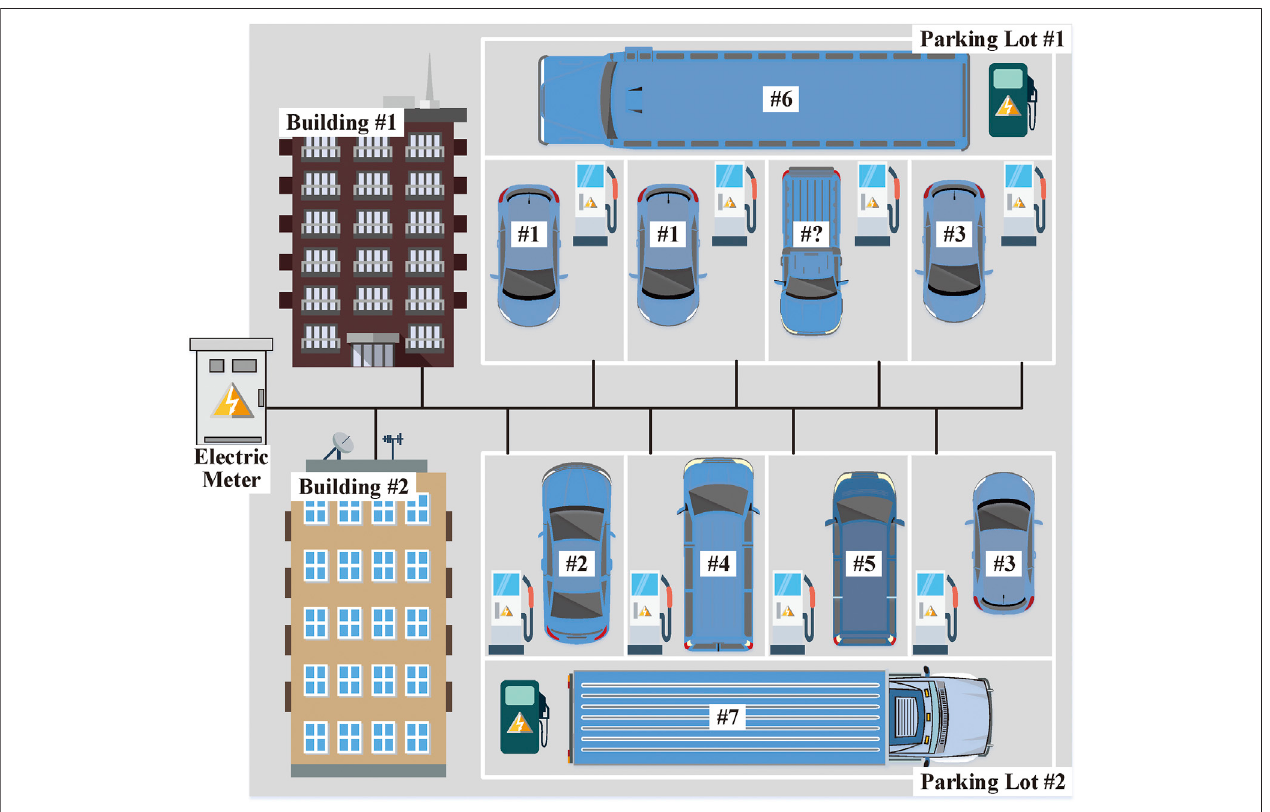
FIGURE 1 | Framework of nonintrusive monitoring for the electric vehicle cluster.